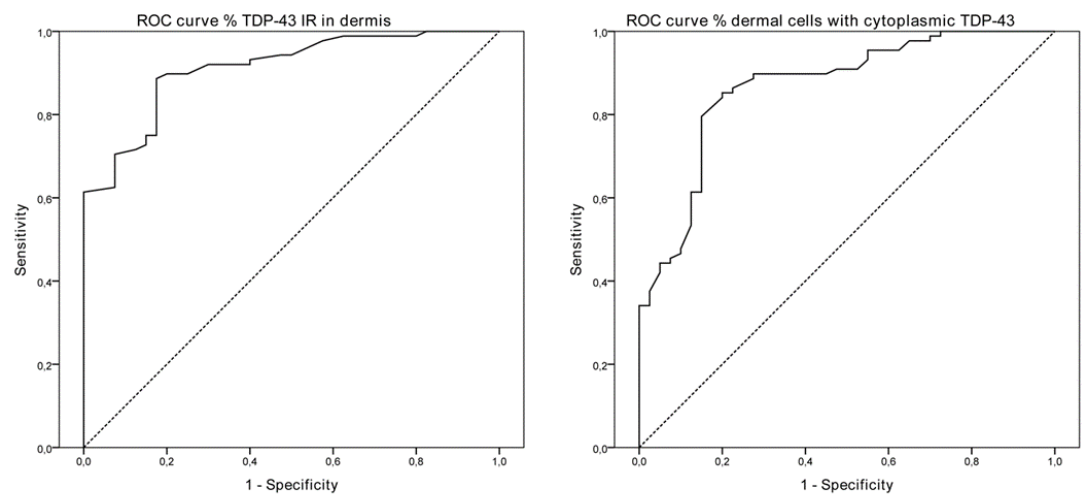
Figure 4. ROC curves of the percentage of TDP-43 immunoreactivity in both layers of the dermis (AUC 0.911, CI 95% 0.862–0.960, p < 0.001) and of the percentage of dermal cells with cytoplasmic TDP-43 labeling (AUC 0.867, CI 95% 0.800–0.935, p < 0.001) in ALS patients. ROC: receiver operation characteristic; AUC: area under the ROC curve. Table 2. TDP-43 quantification and clinical features of ALS patients ( N = 44). IR: immunoreactivity; R: Pearson correlation coefficient.